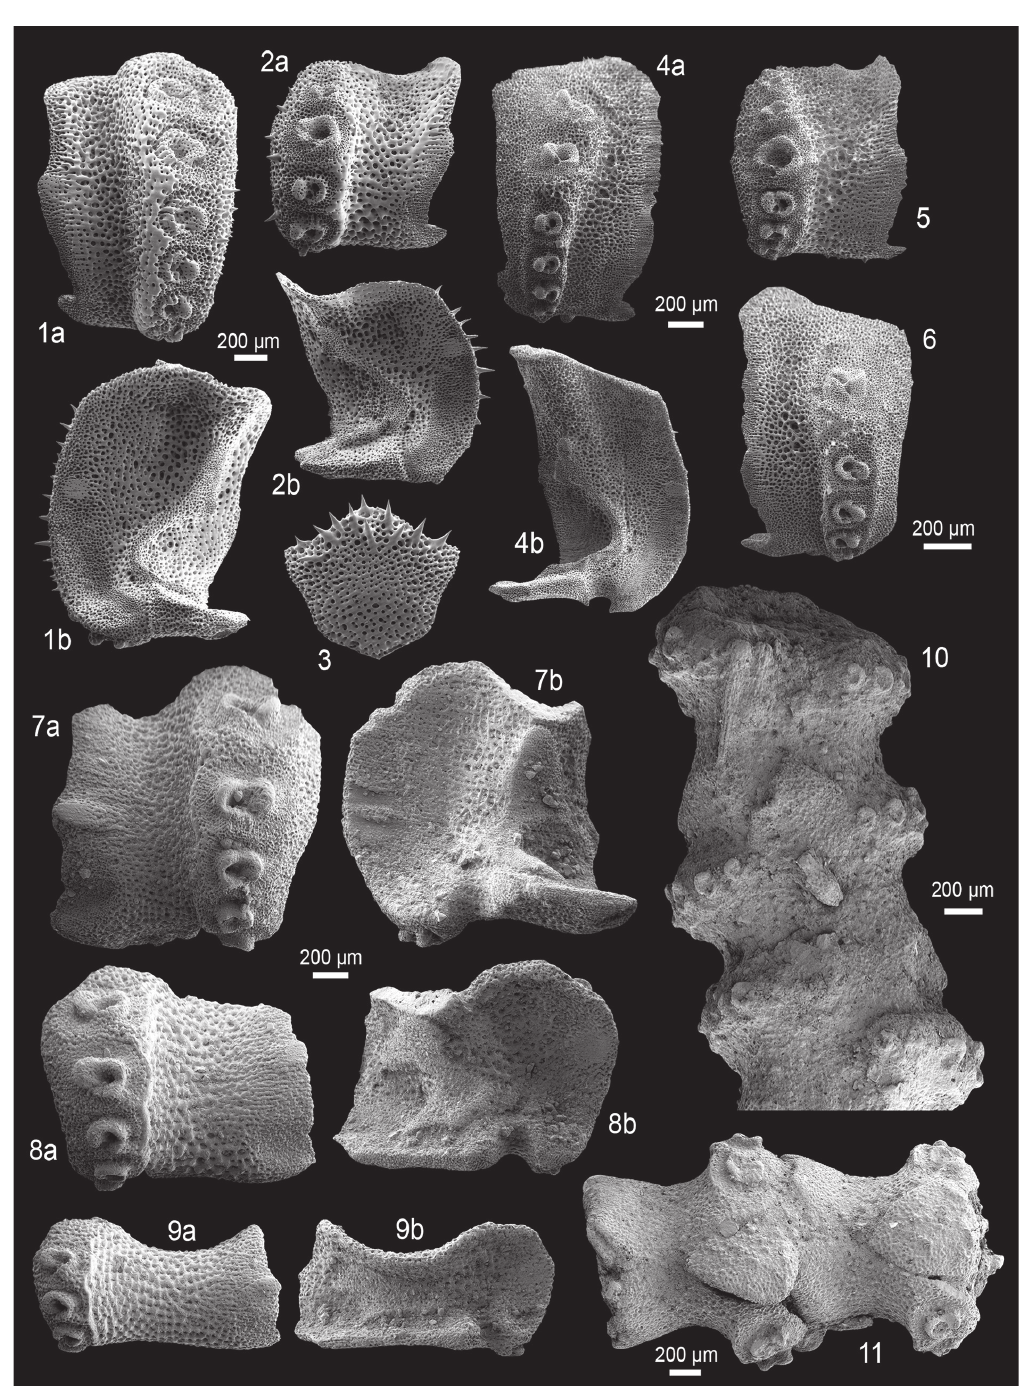
Fig. 35. Skeletal plates and arm fragments of fossil and Recent ophiacanthid brittle stars; lateral arm plates (LAPs) in external (a) and internal (b) views. 1-3. Ophiocamax vitrea Lyman, 1878, Recent. 1. Proximal LAP. 2. Median LAP. 3. Dorsal arm plate. 4-5. Ophiocamax hystrix Lyman, 1878, Recent. 4. Proximal LAP. 5. Median LAP. 6. Ophiocamax austera Verrill, 1899, Recent; proximal LAP. 7-11. Ophiocamax dorotheae sp. nov. from the late Oxfordian (Late Jurassic) of Savigna, France. 7. GZG.INV.78763 (holotype), proximal LAP. 8. GZG.INV.78764 (paratype), median LAP. 9. GZG.INV.78765 (paratype), distal LAP. 10. GZG.INV.78766 (paratype), proximal arm fragment in ventral view. 11. GZG.INV.78767 (paratype), median arm fragment in dorsal view. One common scale bar per species except for 10 and